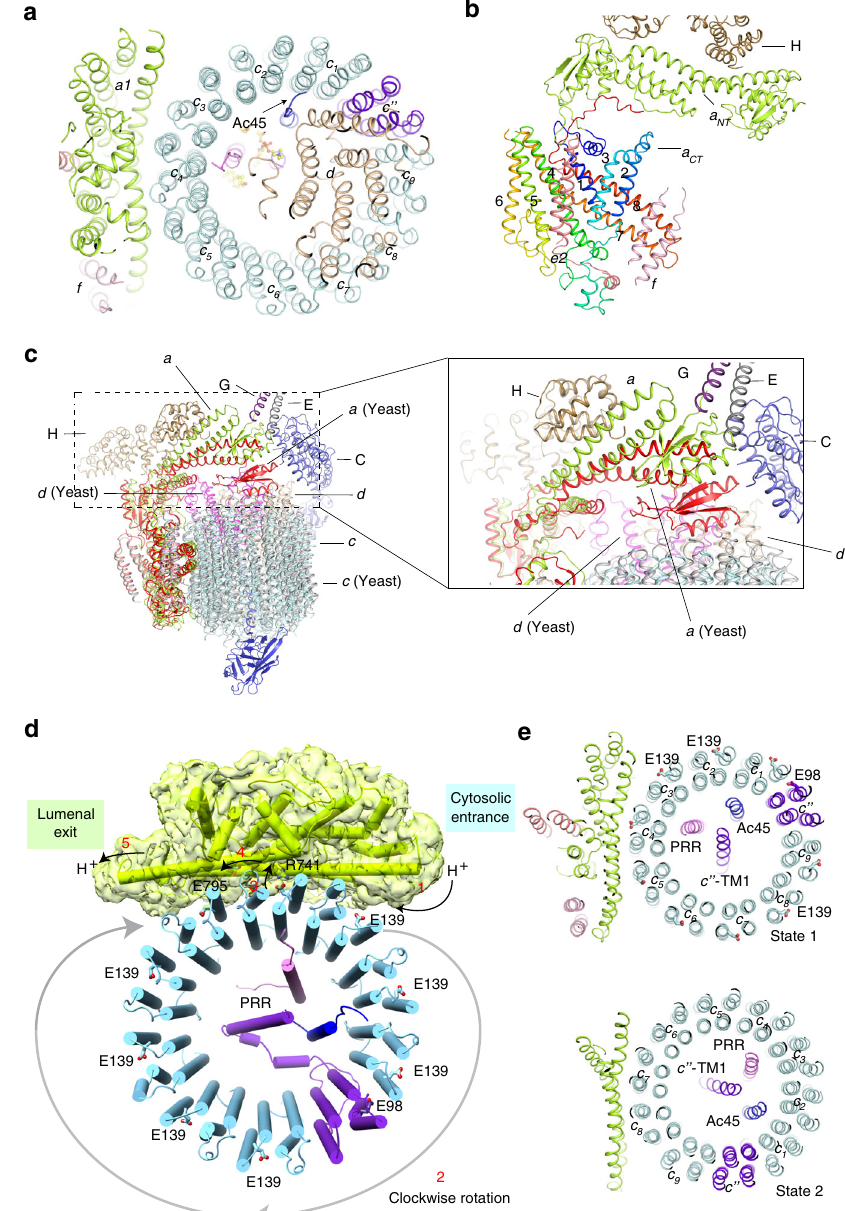
Fig. 5 Proton translocation and the rotation of Vo domain. a Overall structure showing the connection between subunit d and c-ring. b The structural elements of subunit a1 with subunit H, e2, and f. The transmembrane helices of a1 have been labeled. c Structural comparison with auto-inhibitory yeast Vo domain (pdb: 6O7T). d The putative proton-translocation mechanism. The residues for the proton transfer are shown in sticks. The cryo-EM map of subunit a is shown. e The cytosolic view of Vo showing the rotation of c-ring in two states. The Glu residues for protonation in state 1 are shown in